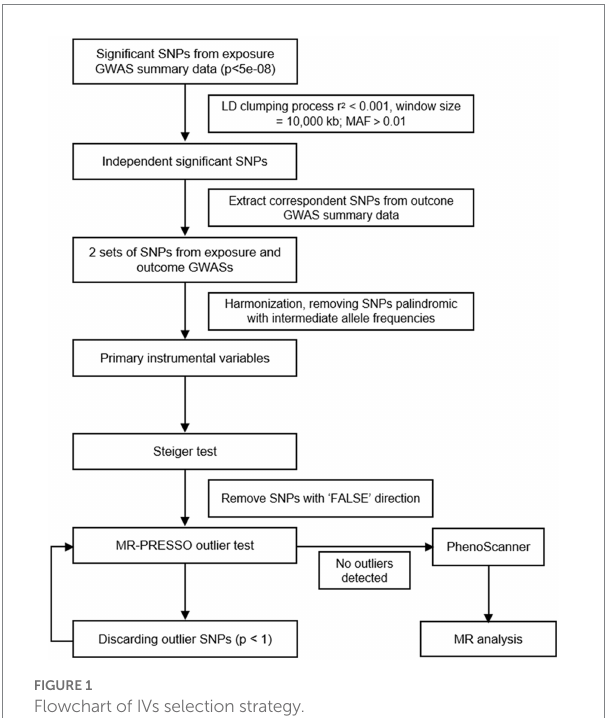
FIGURE 1 Flowchart of IVs selection